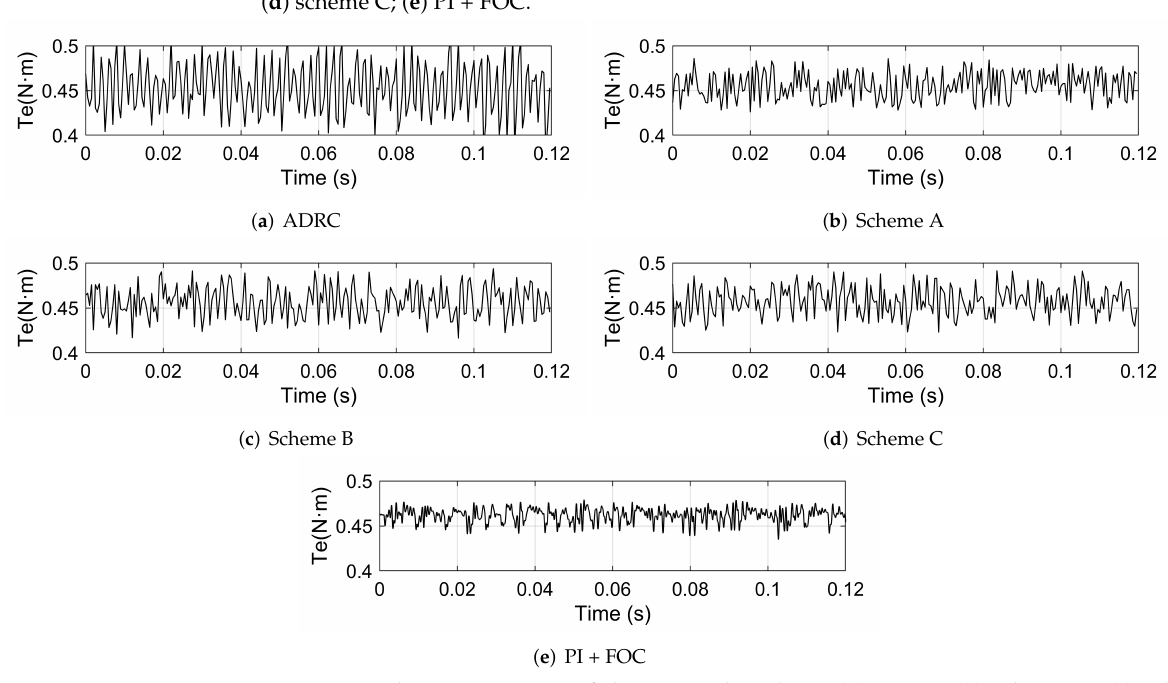
Figure 11. The motor phase current of the system based on: ( a ) ADRC; ( b ) scheme A; ( c ) scheme B; ( d ) scheme C; ( e ) PI + FOC.